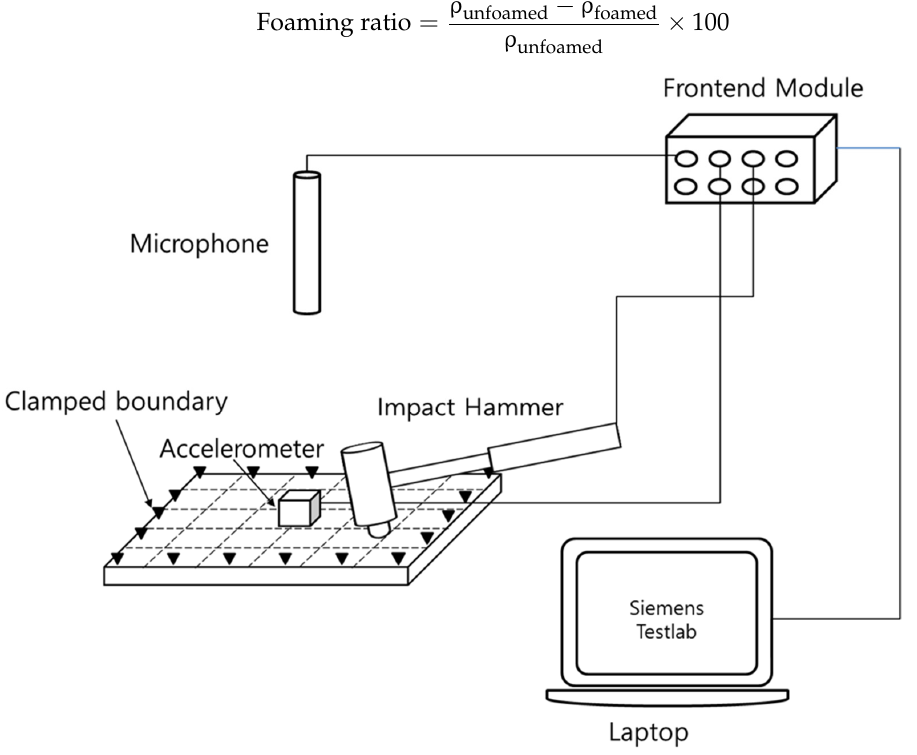
Figure 4. Experimental setup of acoustic and vibration characteristics.